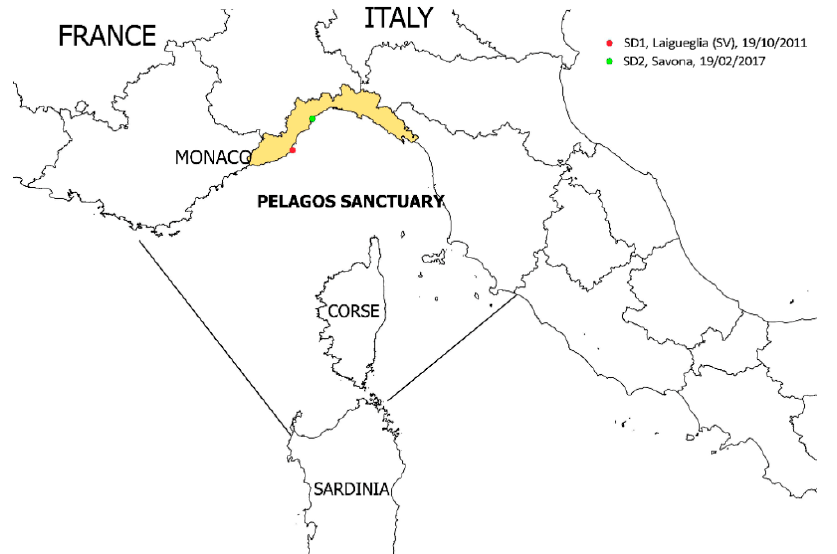
Figure 1. Map of the study area (Ligurian coastline), displaying the stranding locations (red and green dots) of the two striped dolphins infected by Sarcocystidae organisms. The map was created by A.P. with QGIS (QGIS Development Team (2018). QGIS Geographic Information System. Open Source Geospatial Foundation Project. http://qgis.osgeo.org, accessed on 17 August 20).